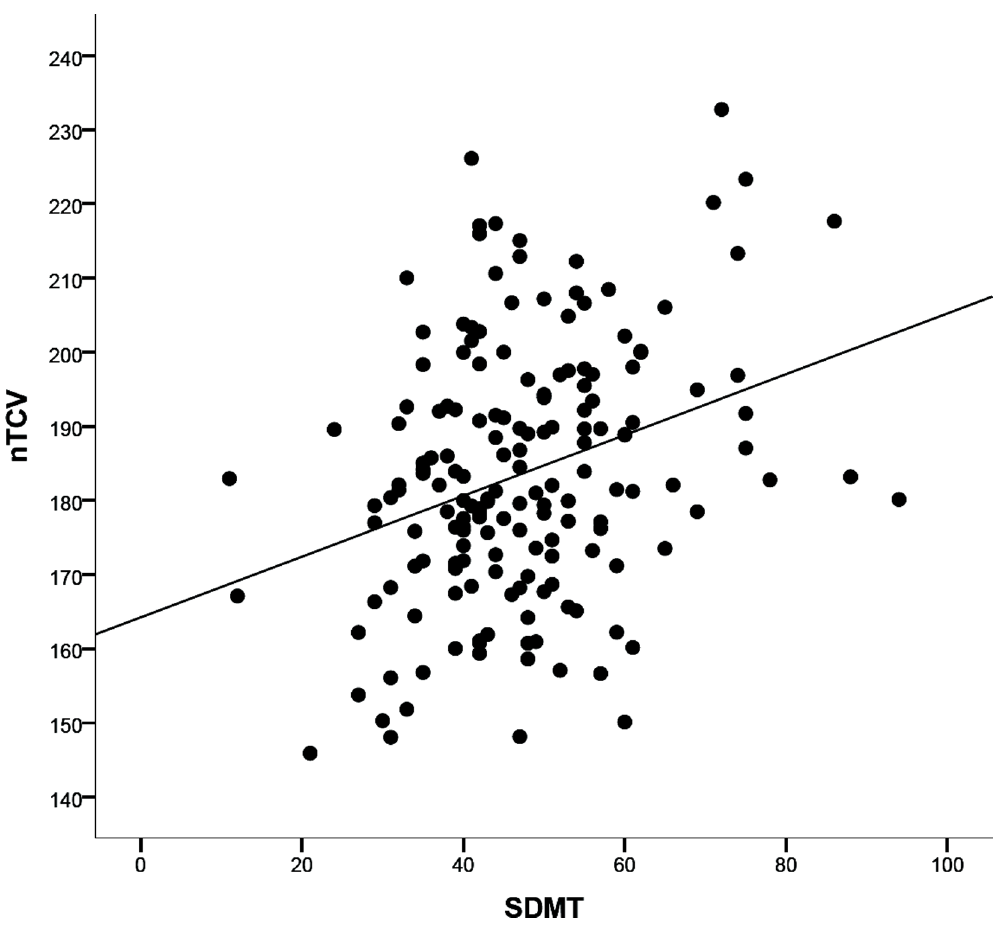
Figure 2. Relation between cerebellar volume and SDMT performance. Scatter plot showing the correlation between normalized total cerebellar volume (nTCV in cm3) vs SDMT performance (score).